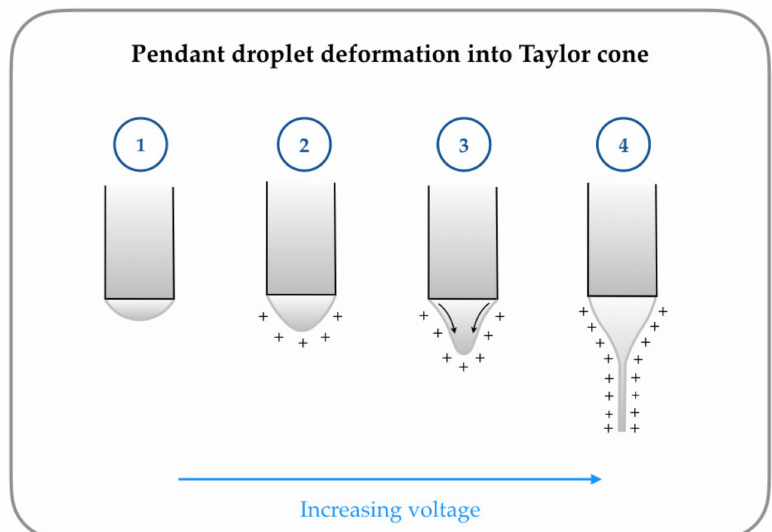
Figure 1. Droplet deformation modes of polymer solution / melt in electrospinning: Mode 1—there is no droplet deformation when there is no voltage. Mode 2—charges accumulate around the droplet on the application of low voltage. Mode 3—Coulombic repulsion overpowers surface tension, and the droplet starts to deform into a Taylor cone. Mode 4—at high voltages, the Taylor cone enters “jetting mode,” and a fibre is extruded from the tip.